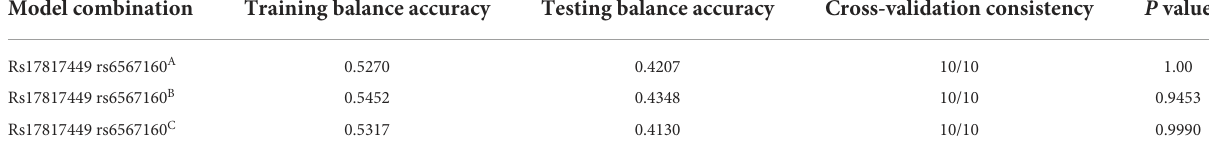
TABLE 3 Gene-gene analyses by the GMDR method ( n = 296). Model